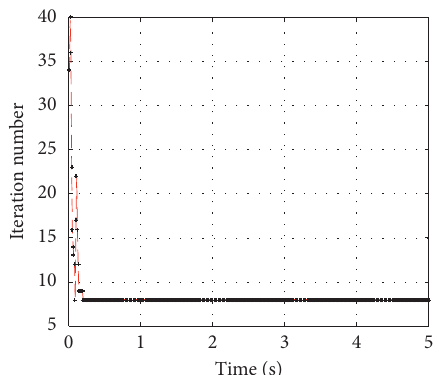
Figure 10: The iteration number of each step.